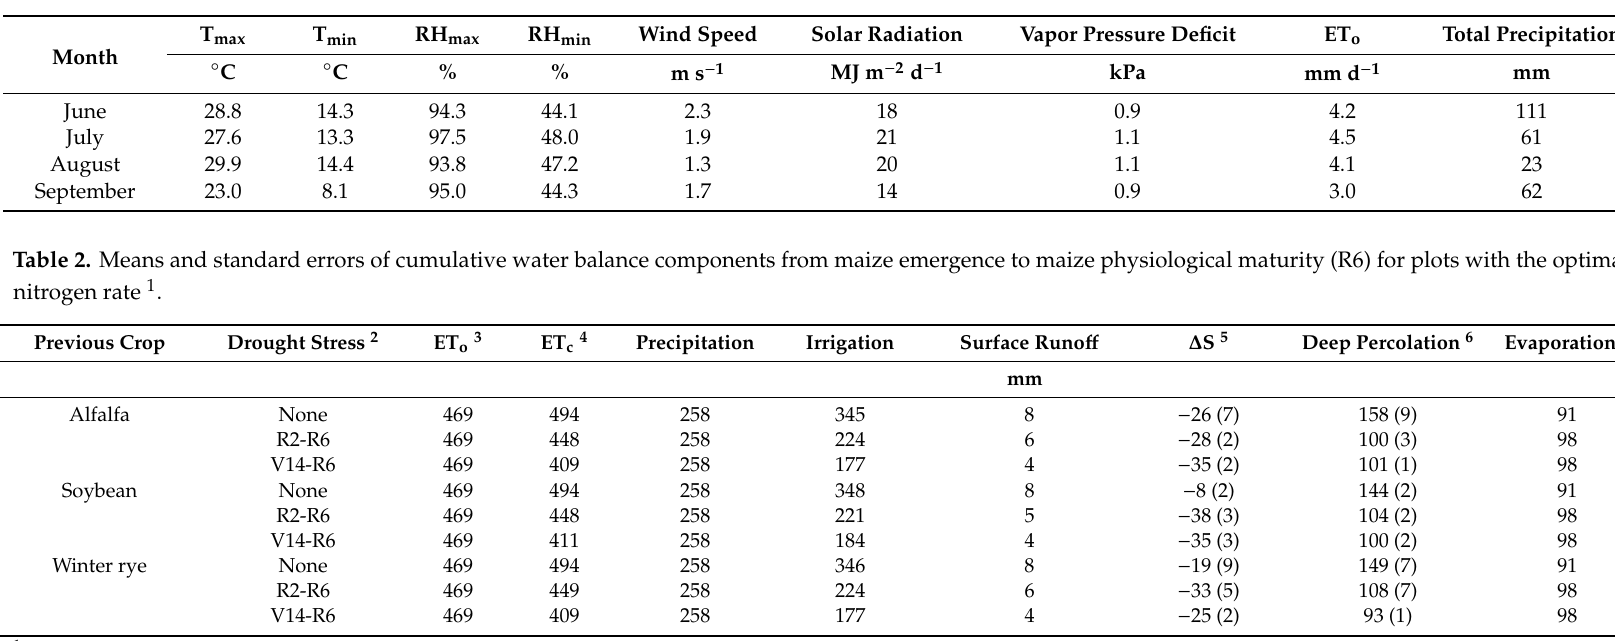
Table 1. Monthly average maximum and minimum air temperature (T max and T min , respectively), maximum and minimum relative humidity (RH max and RH min , respectively), wind speed, solar radiation, vapor pressure deficit, and reference evapotranspiration (ET o ), and monthly total precipitation during the growing season of 2013.